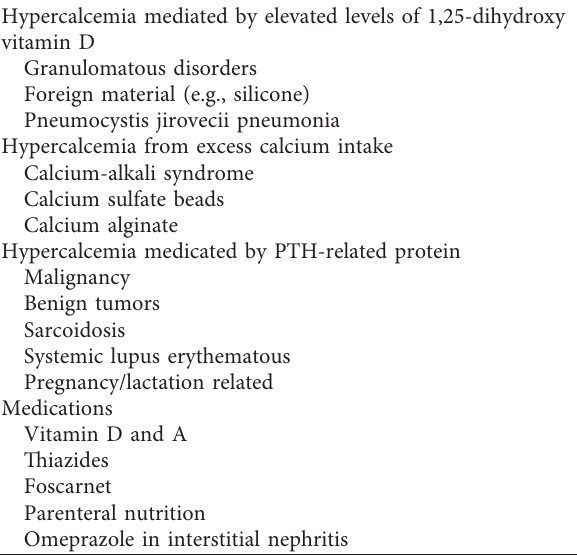
Table 2: Causes of PTH-independent